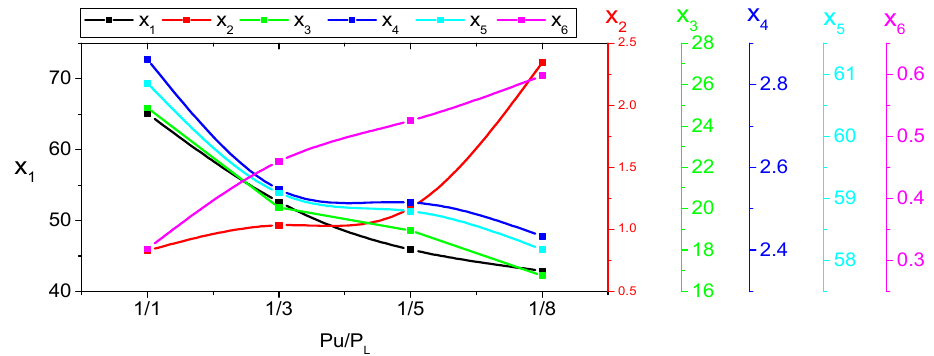
Figure 13. The impact of P u /P L on indicator